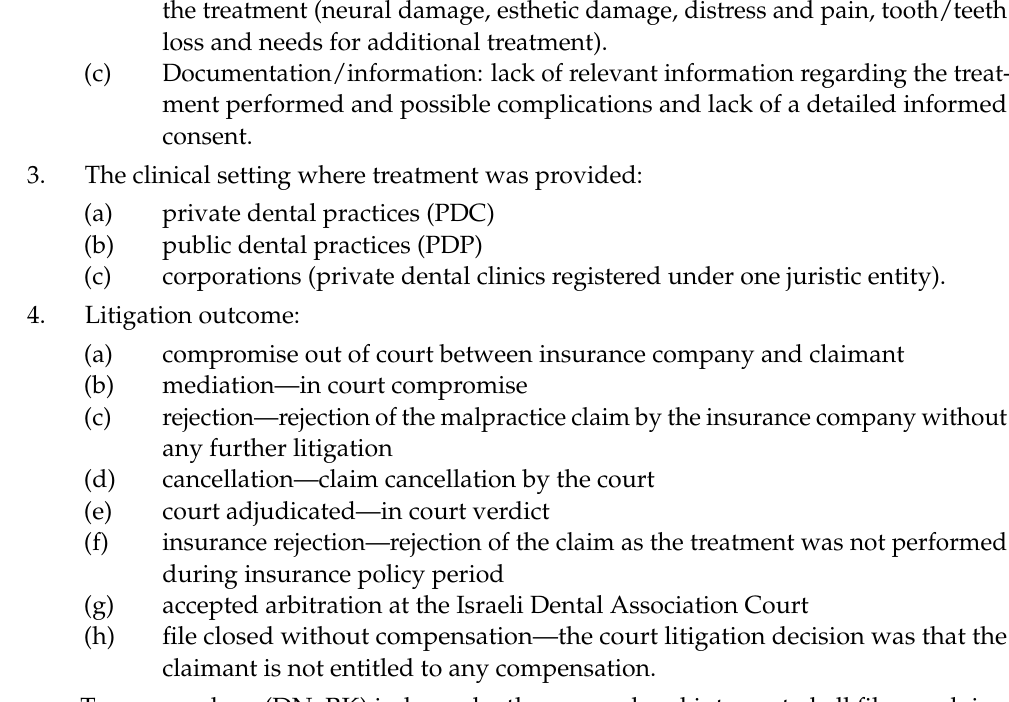
Table 1: The numbers and percentages (%) of claims by patients’ gender and age, treatment setting, and litigation results in a cohort of 508 patients. Women made up 63.4% of the cohort (322/508). The average age of the claimants was 44.62 ± 14.83 years (range 11–84, median—45.00) and 71.3% (362/508) of the patients were more than 35 years old (Table